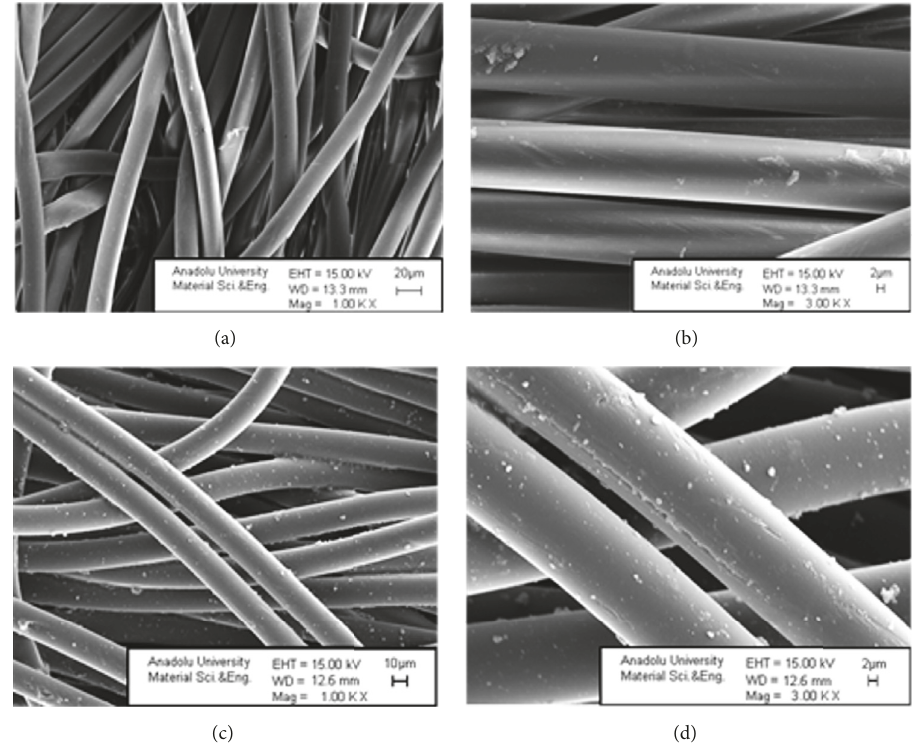
Figure 5: SEM test results of fabric samples. (a) Reference fabric (1,000X); (b) reference fabric (3,000X); (c) Z100 (1,000X); (d) Z100 (3,000X).